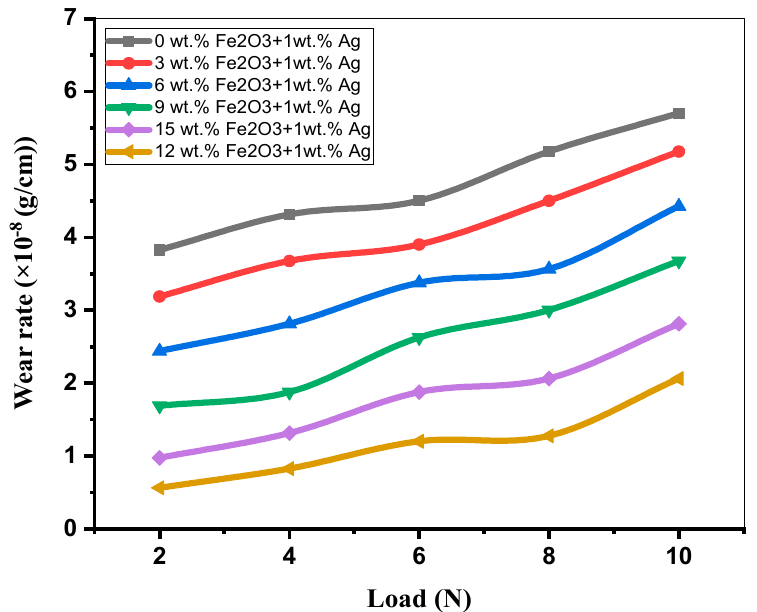
Figure 4. The variation of wear rate as a function of normal loads for pure Al and Al/Fe 2 O 3 + Ag hybrid nano ‐ composites.